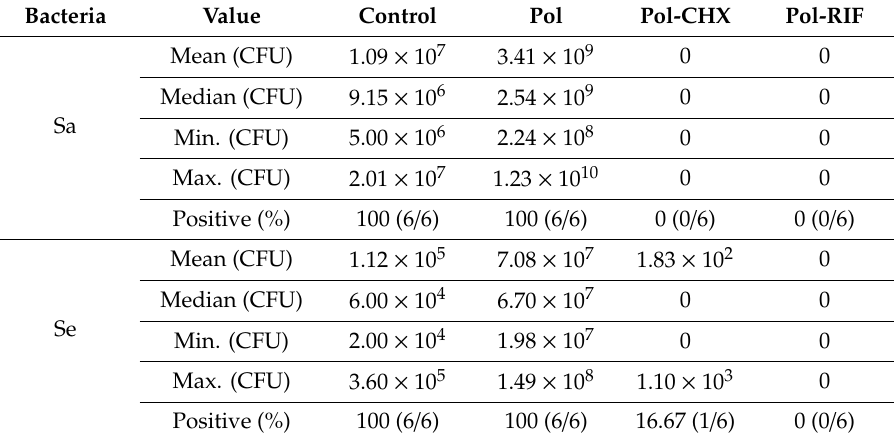
Table 1. Bacterial adhesion to the surface of the di ff erent materials. Results were expressed as mean, median, minimum, and maximum bacterial loads (recorded as colony forming units, CFU) yielded per study group and bacteria ( n = 6 each). The percentage of samples yielding positive counts (%) is provided.